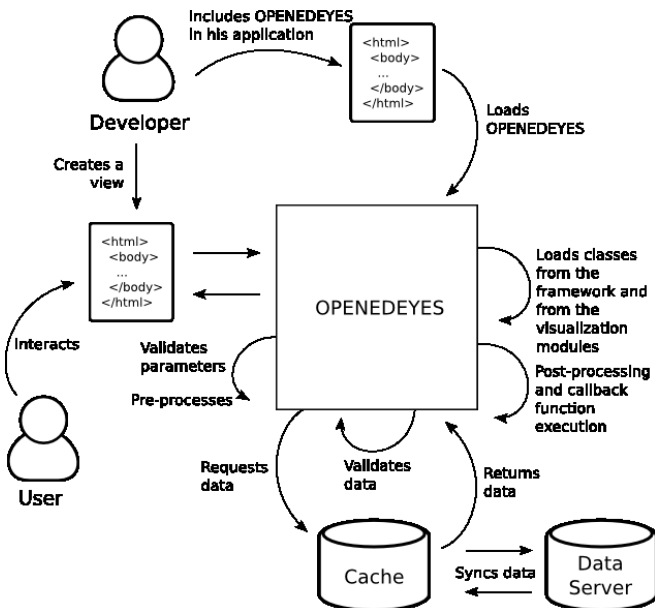
Fig. 2. Global execution flow of OPENEDEYES